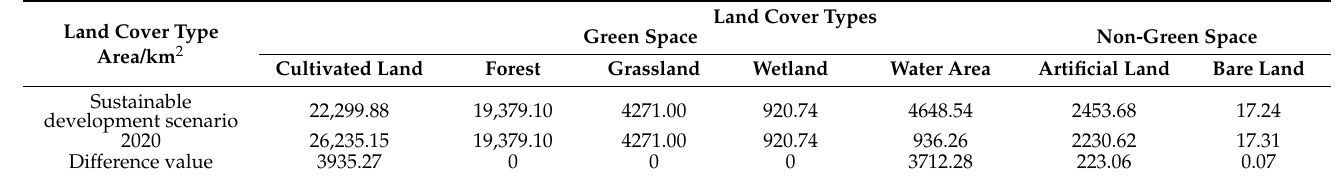
Table 6. Land cover type areas in the sustainable development scenario compared to those in 2020.